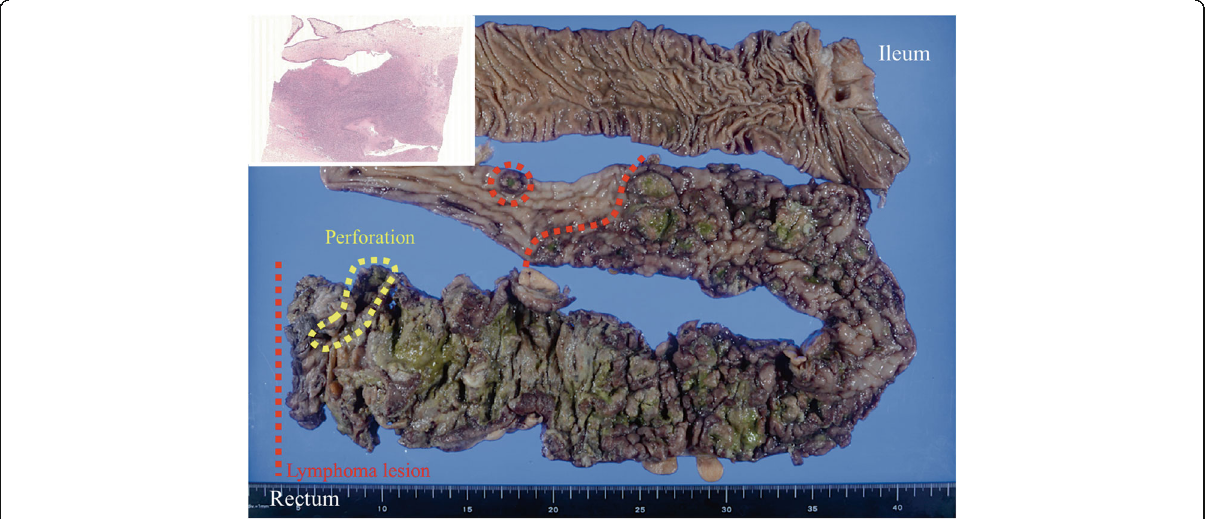
Fig. 1 Total proctocolectomy specimen: Diffuse, irregular thickening of the colorectal wall extends from the middle of the transverse colon ( red broken lines ) to the rectum with a rectal perforation ( yellow circular broken line ). The image of perforation department is shown ( Inset